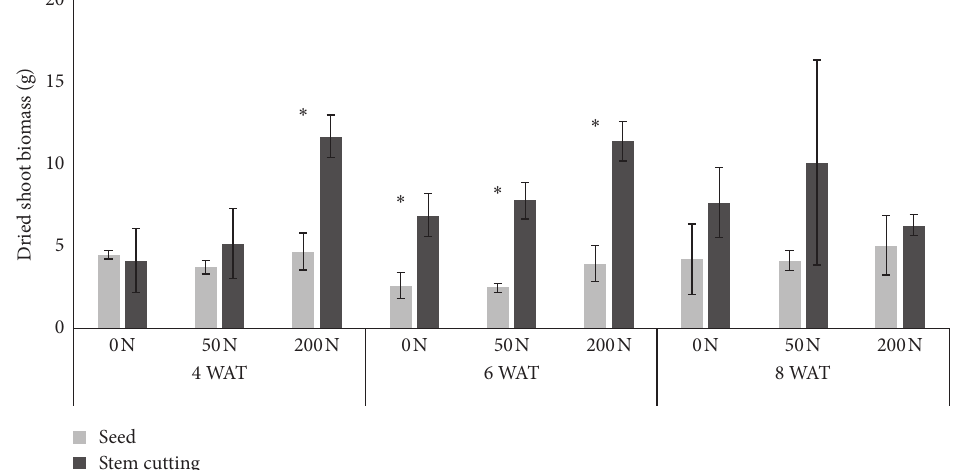
Figure 4: Dried shoot biomass (g) of E. pellita seedlings from seeds and stem cutting plant materials at different nitrogen concentrations (0, 50, 200kg N ha − 1 ) at three selected dates of root measurement: 4 weeks after transplanting, WAT, 6 WAT, and 8 WAT. The mean values were tested using independent samples t -test between seed and stem cutting propagation for each fertilizer treatment and date. All mean values were significantly different ∗ ( P < 0 . 05). Error bars denote standard deviations of the mean ( n �